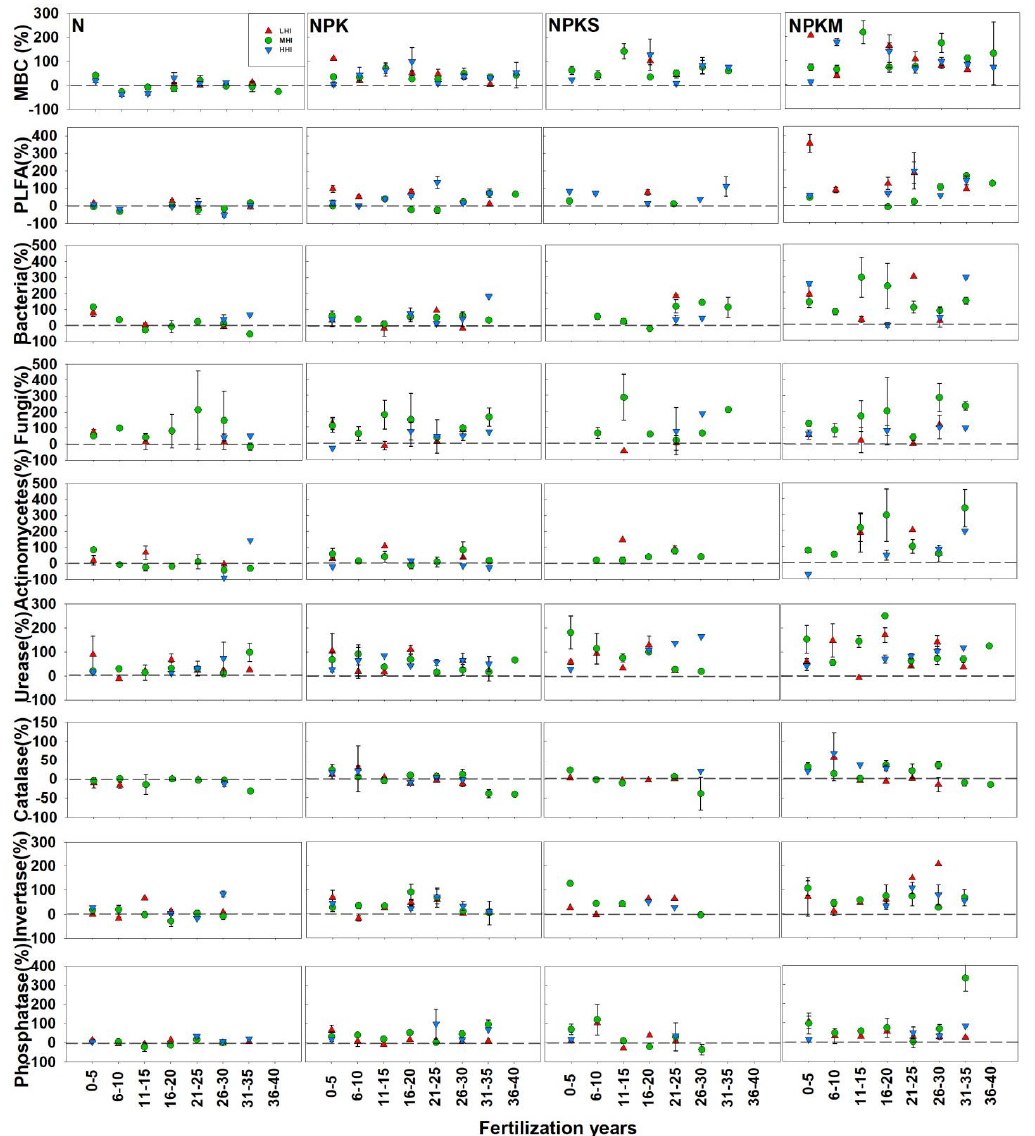
Figure 5. The effect sizes of fertilization duration on soil microbial properties (MBC, MBN, the Shannon index, PLFA, bacteria, fungi, Actinomycetes , urease, catalase, invertase, and phosphatase) with different HI (red triangle: HI ≤ 25; green circle: 25 < HI < 50; blue inverted triangle: HI ≥ 50) and four main fertilizer regimes (N, NPK, NPKS, and NKPM). N: sole nitrogen fertilizer; NPK: the phosphorus, potassium, and nitrogen fertilizer; NPKS: NPK combined with straw; NPKM: NPK combined with manure.